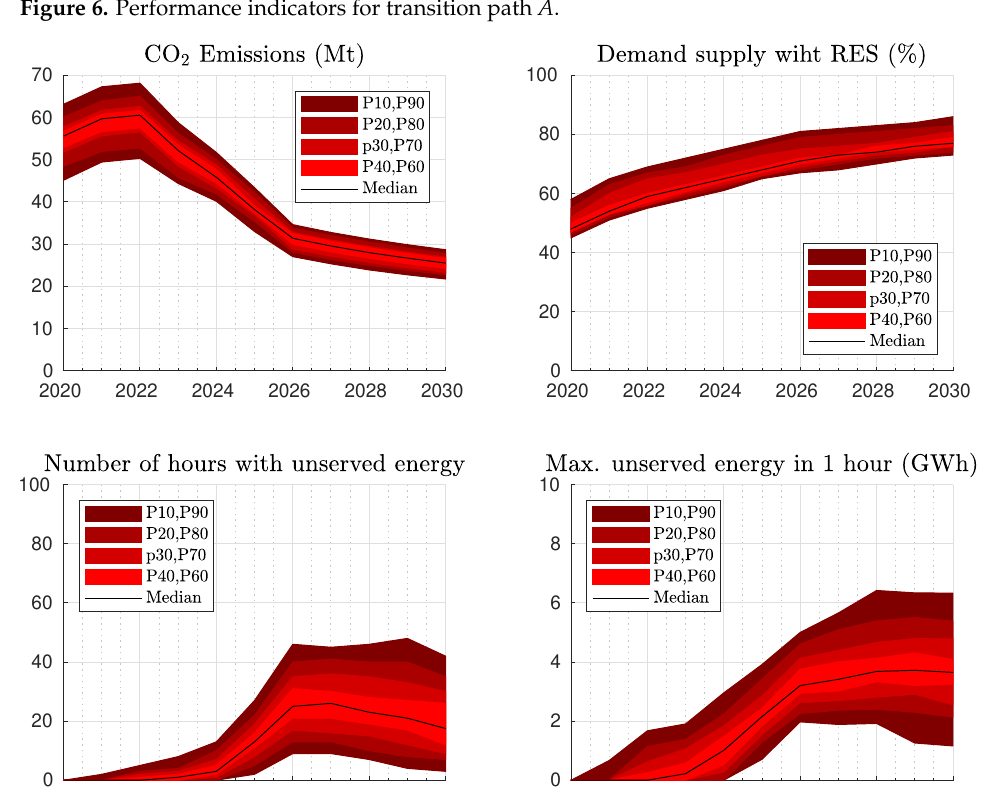
Figure 7. Performance indicators for transition path A+